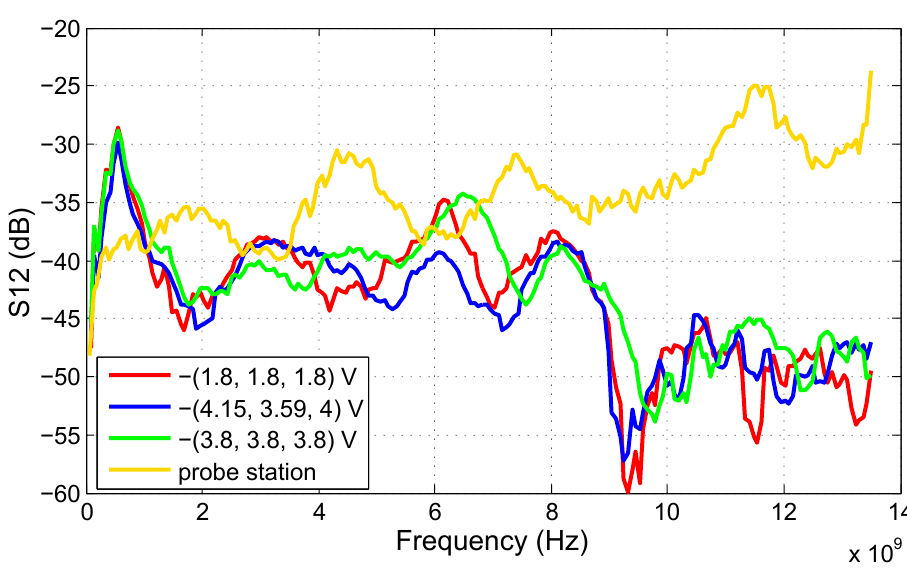
Figure 15. S12 of the proposed ECC bandpass